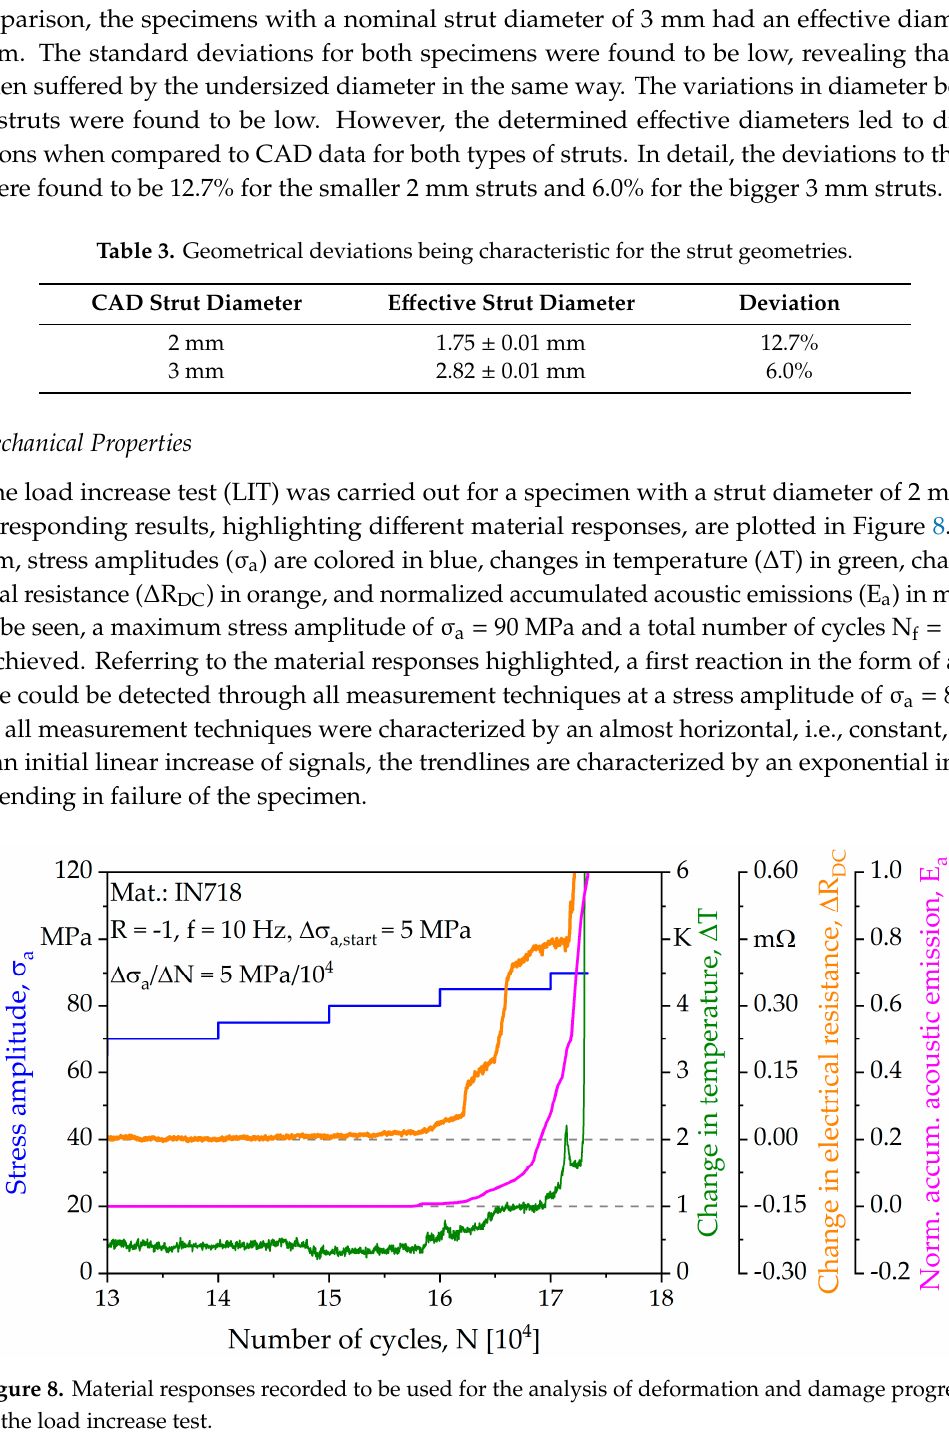
in the load increase